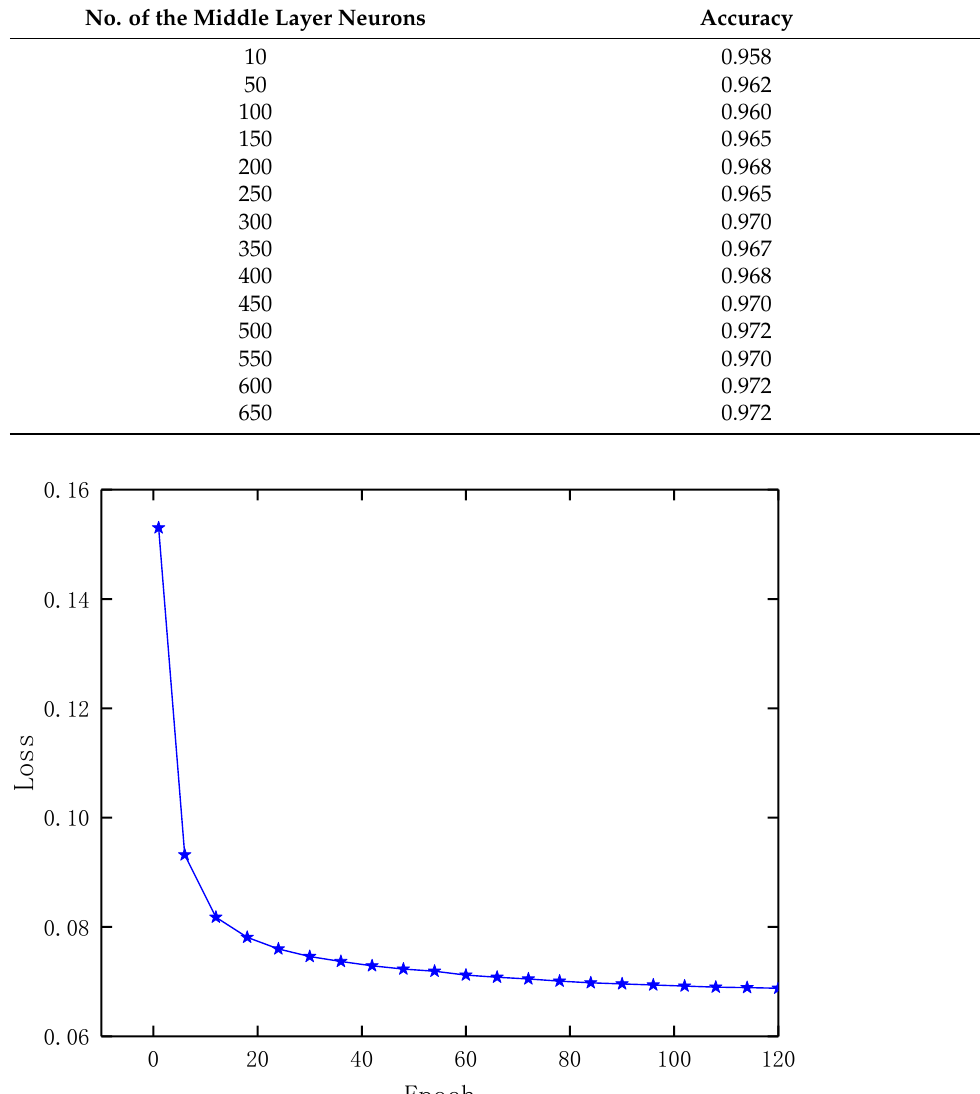
Table 1. The accuracy variation with the number of middle-layer neurons.